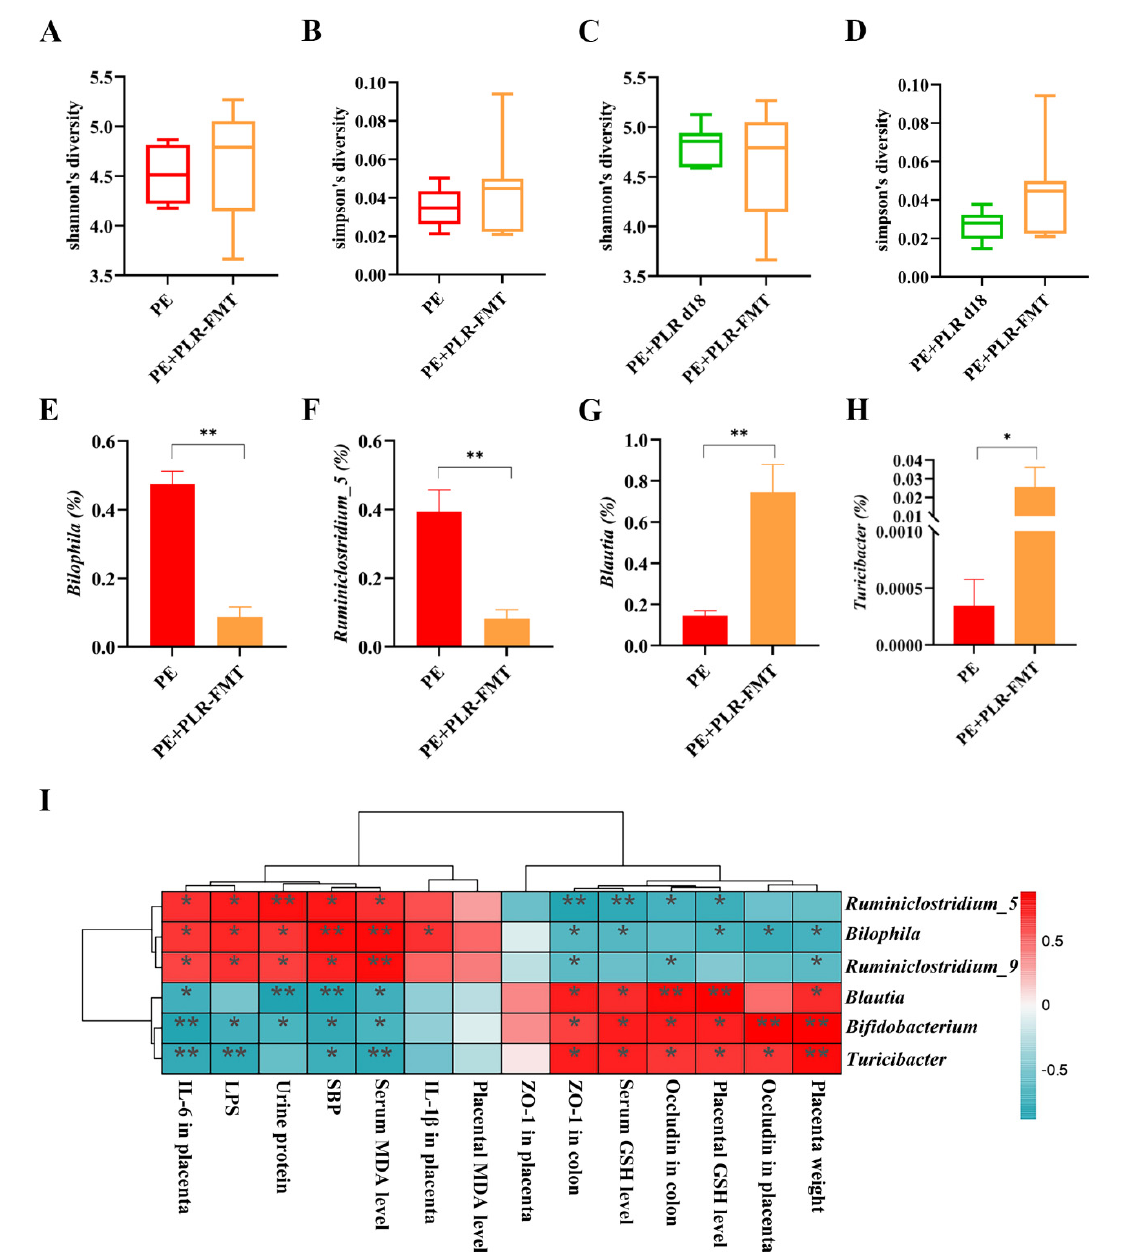
Figure 9. FMT altered the composition of gut microbiota in PE mice. ( A , B ) Comparison of α -Diversity in the PE group and the PE+PLR-FMT group. ( C , D ) Comparison of α -Diversity in the PE+PLR d18 group and the PE+PLR-FMT group. ( E – H ) Relative abundances of Bilophila, Ruminiclostridium_5 , Blautia , and Turicibacter between the PE group and the PE+PLR-FMT group. ( I ) Correlation heatmap of differentially abundant microbial genera and representative indicators. In this figure, n = 6–8 for each group. Data are expressed as the mean ± SEM. * p < 0.05, ** p < 0.01 (Wilcoxon rank–sum test).